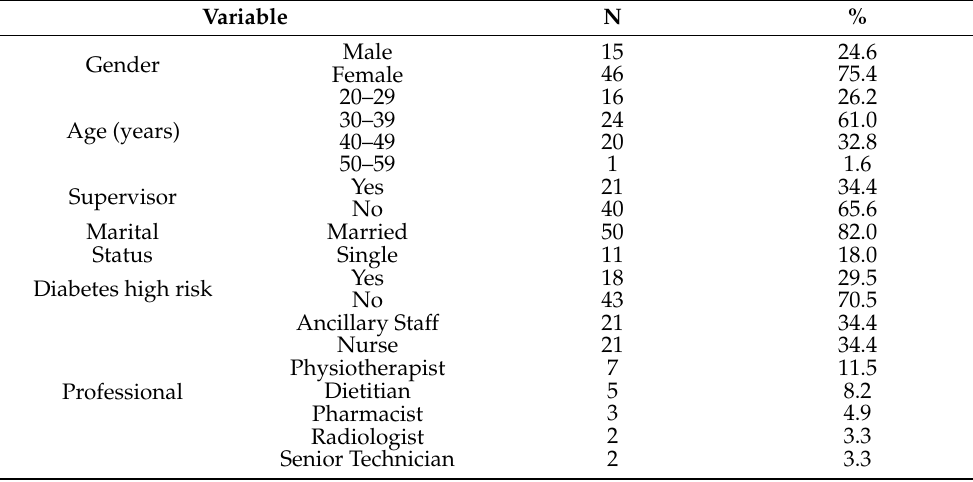
Table 1. Characteristics of the diabetic healthcare volunteers.